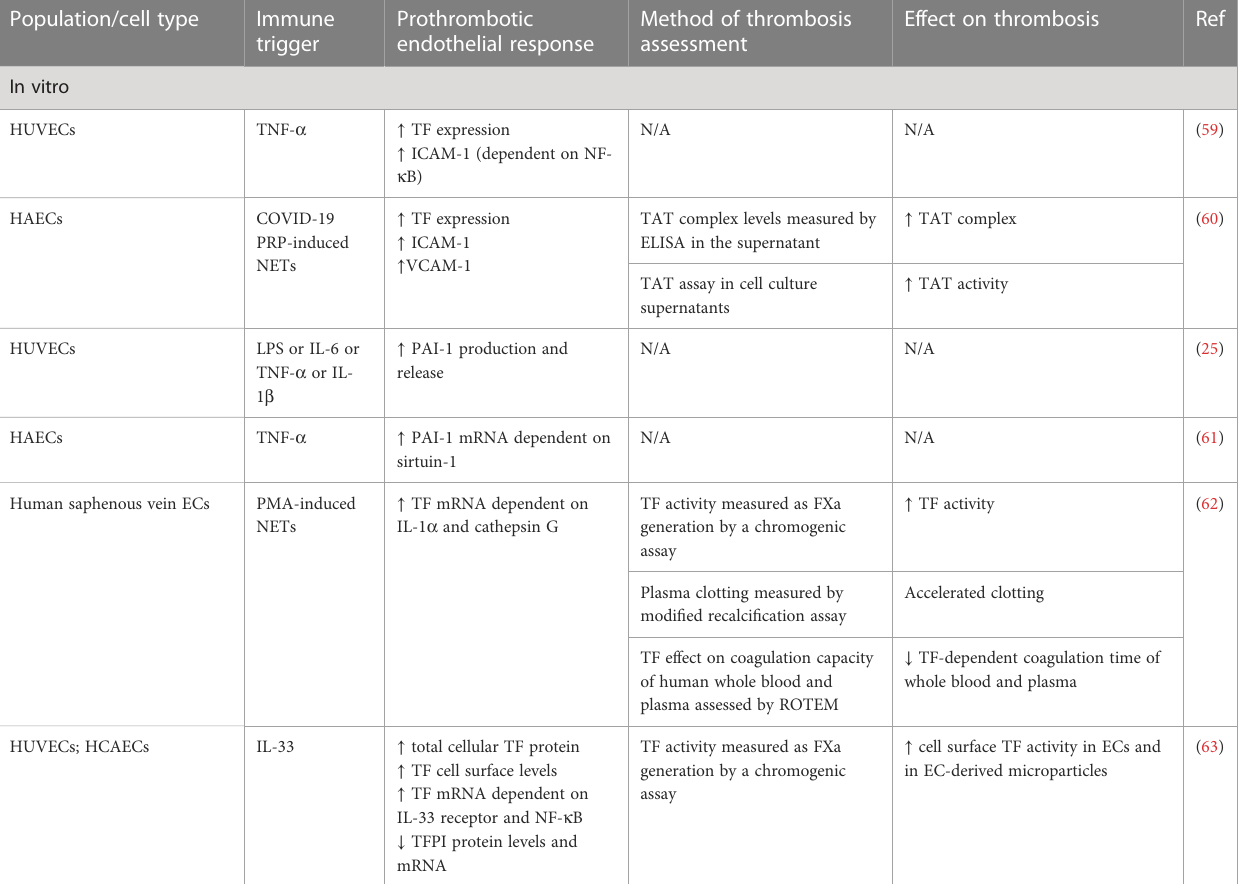
TABLE 1 Role of endothelial cells in